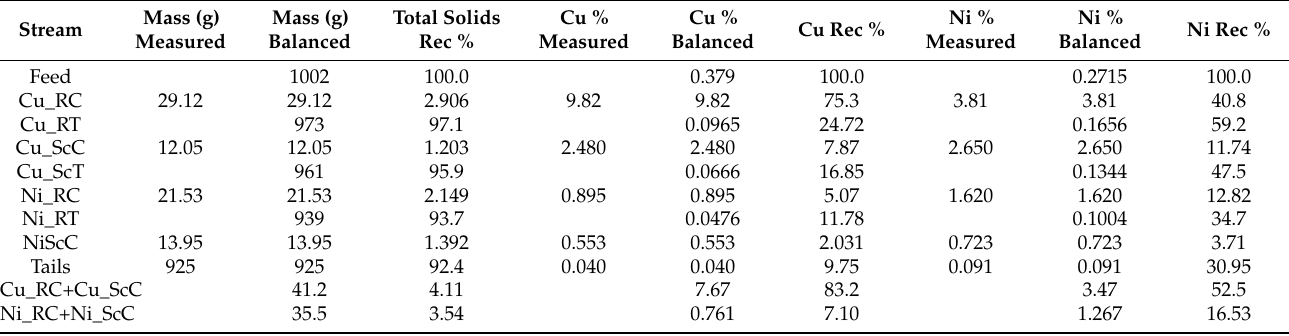
Table A6. Mass balance for flotation test Sep